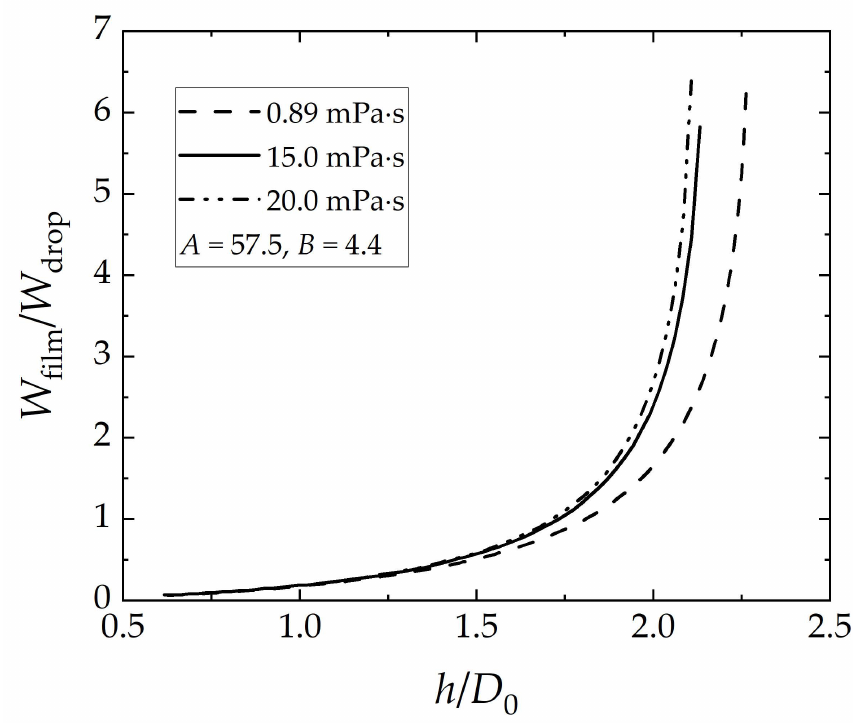
Figure 6. Ratio of viscous dissipation of energy in the film and the drop versus the film thickness. The plotted curves are generated using the values found for parameters A , B (Figure